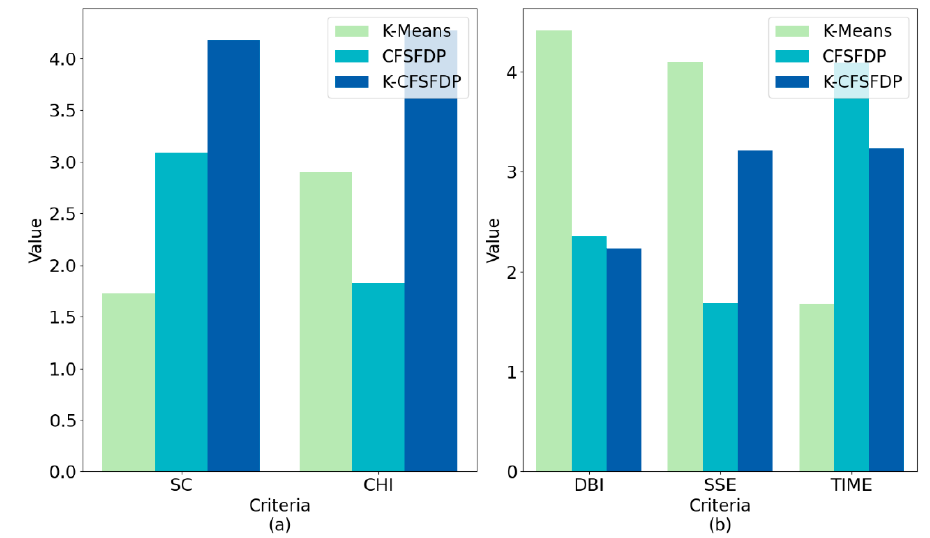
Figure 17. Clustering performances of three models under different evaluation criteria in dataset S2: ( a ) the higher the value, the better and ( b ) the lower the value, the better.